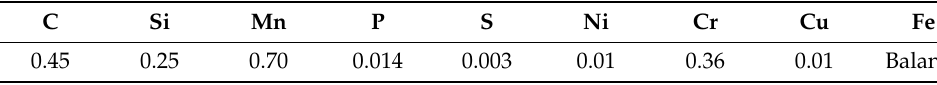
Table 2. Chemical composition of medium-carbon steel.